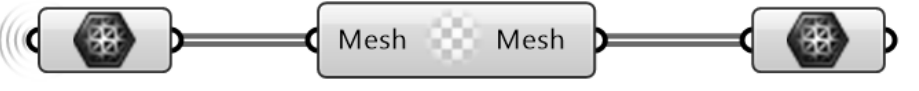
Figure 8. The component that adds a middle node on all mesh edges for quadratic finite